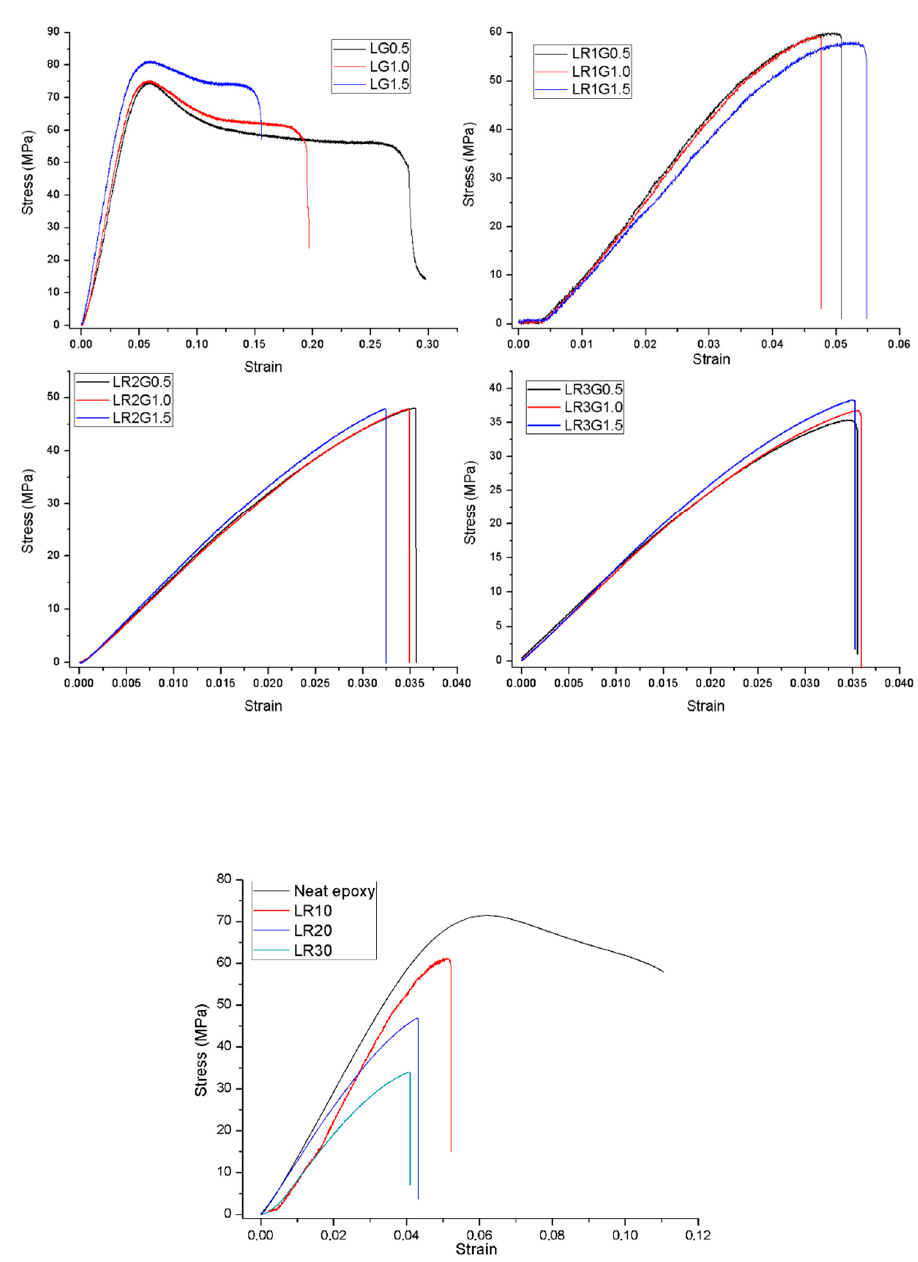
Figure 2. Engineering stress–strain curves of the manufactured composites.